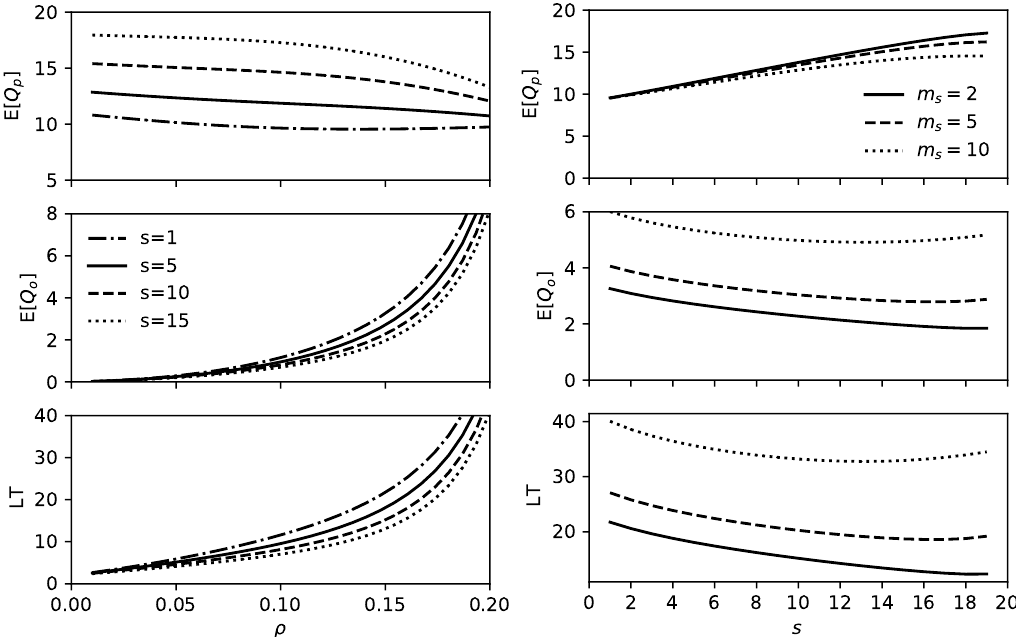
Figure 2. Mean inventory level, mean backlog and mean lead times vs. the order arrival load for different values of the threshold s ( left ) and vs. the threshold s for different values of the mean MTO/MTS switching time m s ( right